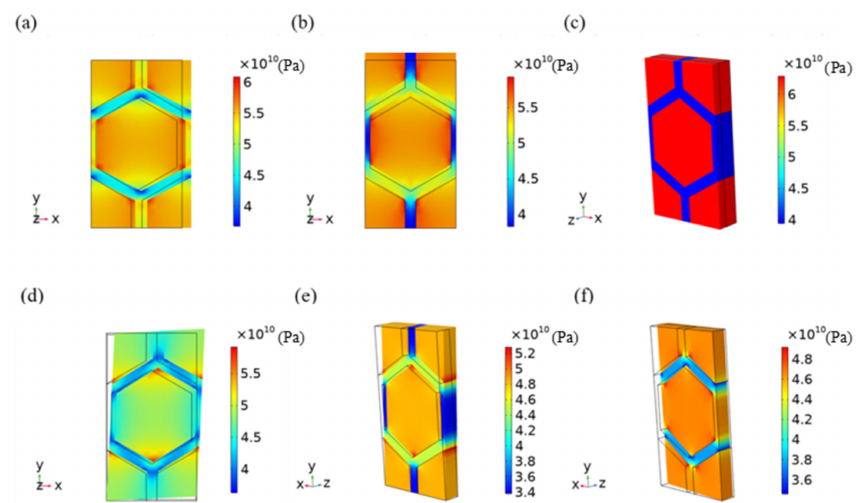
Figure 10. Stress distribution cloud diagrams of the EAS-Nb 3 Sn level 2 homogeneous superconduct- ing region considering fiber damage when T = 4 K and ε = 0.003. ( a ) Load case 1: von Mises stress (N/m 2 ). ( b ) Load case 2: von Mises stress (N/m 2 ). ( c ) Load case 3: von Mises stress (N/m 2 ). ( d ) Load case 4: von Mises stress (N/m 2 ). ( e ) Load case 5: von Mises stress (N/m 2 ). ( f ) Load case 6: von Mises stress (N/m 2 ).